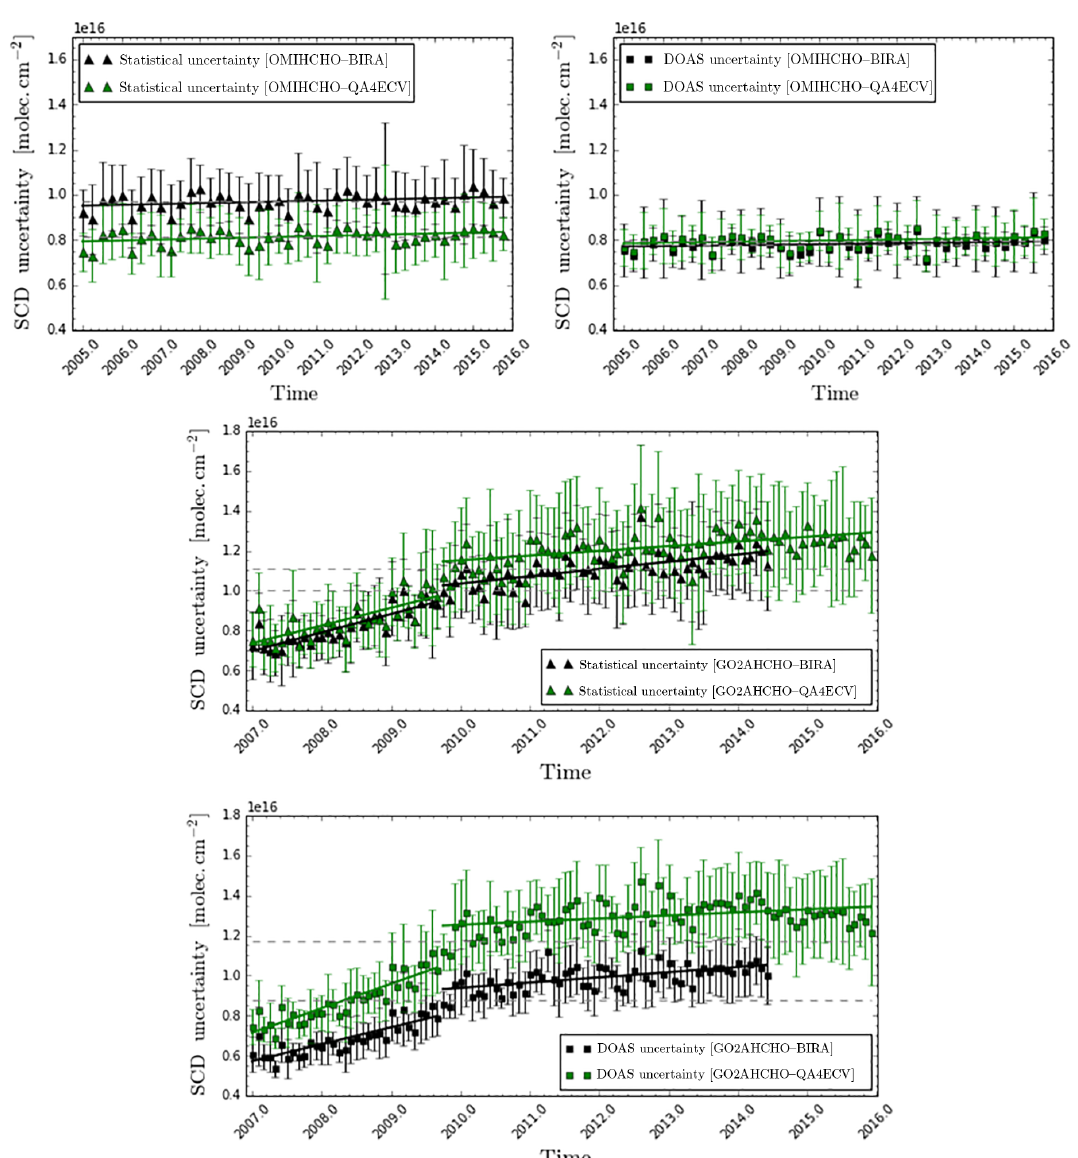
Figure 12. Temporal evolution of the statistical (triangles) and DOAS (squares) OMI and GOME-2A HCHO SCD uncertainty for OMIHCHO–BIRA (black) and OMIHCHO–QA4ECV (green) (Pacific orbit from day 1 of January, April, July, and October (or closest available data) 2005–2015), and for GO2AHCHO–BIRA (black) and GO2AHCHO–QA4ECV (green) (Pacific orbit from day 1 of January up to December and from day 15 of January, April, July, and October 2007–June 2014 and 2007–2015, respectively) for the sub-periods before and after the second throughput test (September 2009). Error bars represent 1 standard deviation (1 σ) . Solid lines represent the linear regressions fitted to the data for each sub-period (Table 8). The slope, p , of each fit on the statistical, p s , and DOAS uncertainty, p d , for OMIHCHO